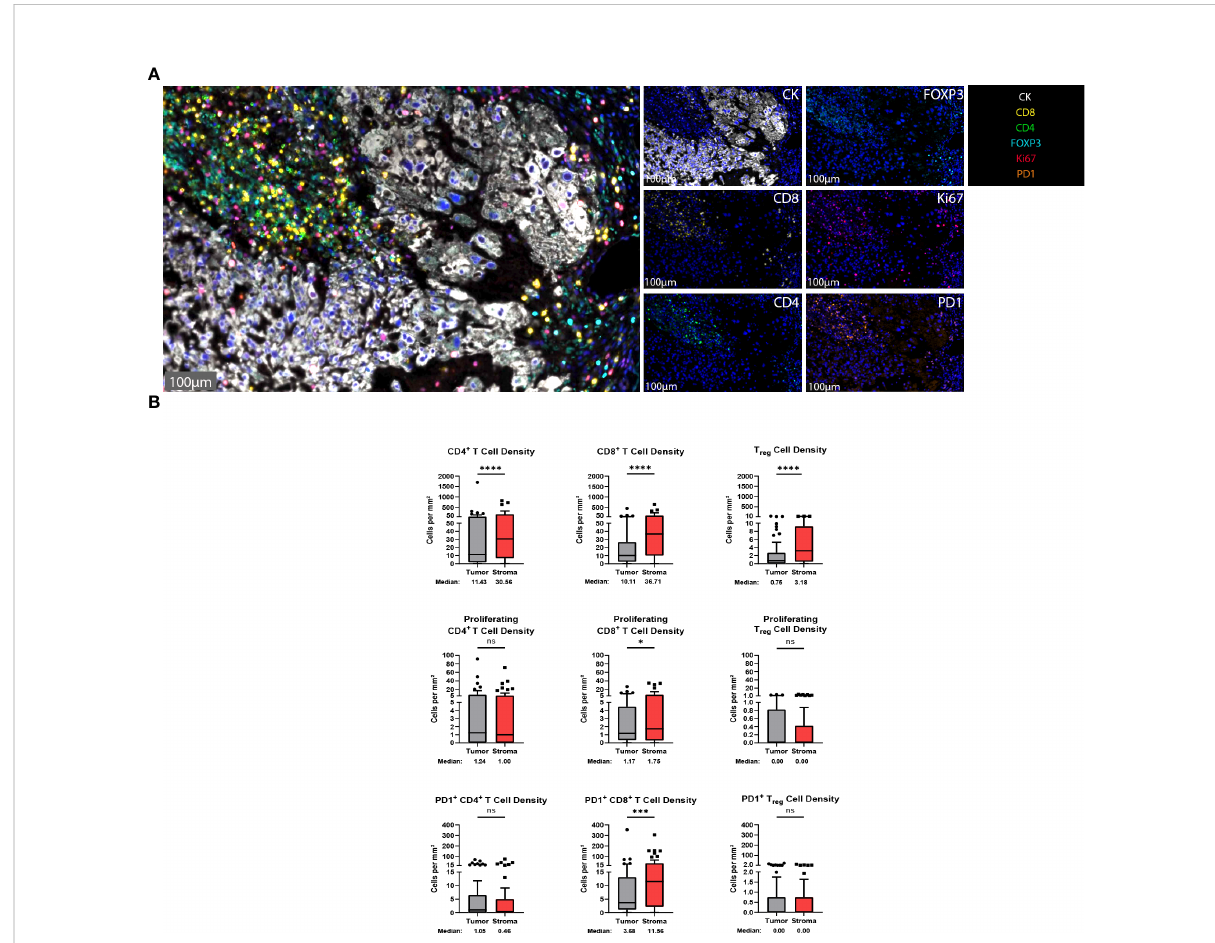
FIGURE 2 T cells are found in abundance within the chordoma tumor immune microenvironment, most often within the stroma. (A) Representative photomicrographs from one chordoma of merged and single-color immuno fl uorescence images assessing the presence of T cells with a validated panel of six biomarkers, CD8 (yellow, Opal 570), CD4 (green, Opal 520), FOXP3 (turquoise, Opal 480), Ki67 (red, Opal 690), PD1 (orange, Opal 620), and CK (white, Opal 780). Multispectral immuno fl uorescence images are counterstained with DAPI. Expression of CD4 without CD8 and FOXP3 identi fi ed CD4 + T helper cells, while expression of CD8 without CD4 and FOXP3 identi fi ed CD8 + cytotoxic effector T cells. Co-localization of CD4 and FOXP3 without CD8 identi fi ed T regs . T cells with positive Ki67 nuclear expression were proliferating, and PD1 positivity denoted PD1 + T cells. Expression of CK identi fi ed chordoma tumor cells. (B) Quanti fi cation of CD4 + T cell, CD8 + T cell, and T reg cell density (per mm 2) , as well as proliferating and PD-1 + subcategories of these are compared between chordoma tumor and stroma (n = 57 individual tumors). Wilcoxon signed rank tests with p value threshold of <0.05 were used to compare tumor and stroma T cell in fi ltrate. * p ≤ 0.05, *** p ≤ 0.001, **** p ≤ 0.0001, ns, non signi fi cant. CK, cytokeratin; DAPI, 4 ′ ,6-diamidino-2- phenylindole; PD1, programmed cell death protein